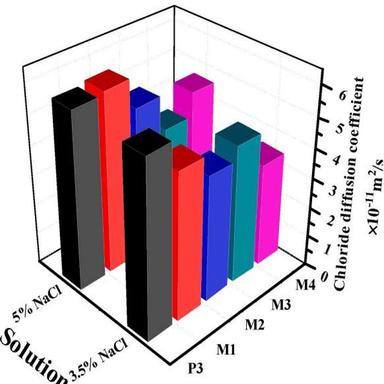
Depicts the steady-state chloride ion diffusion coefficients of saturated filled samples in various concentrations of NaCl solution.